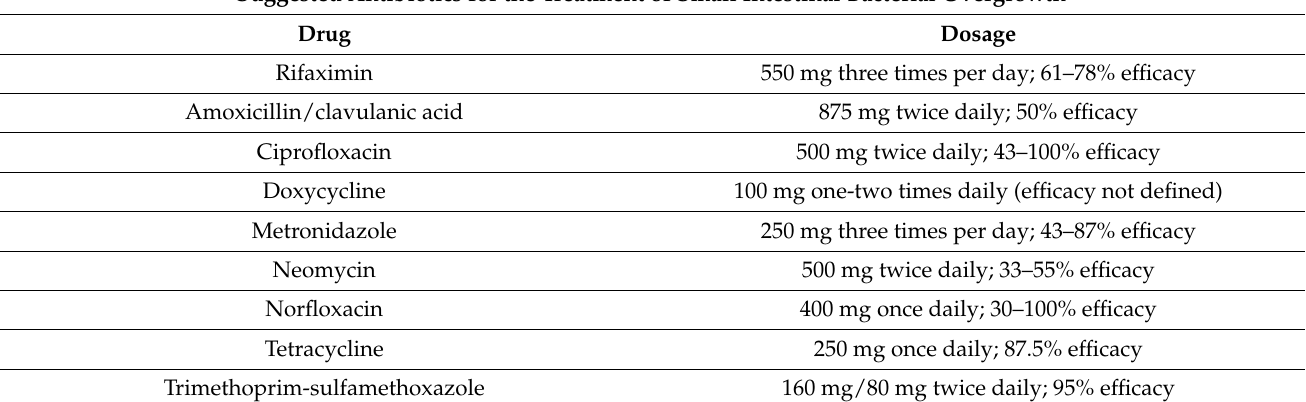
Table 1. American College of Gastroenterology (ACG) developed guidelines for the use of antibiotics [51]. Suggested Antibiotics for the Treatment of Small Intestinal Bacterial Overgrowth